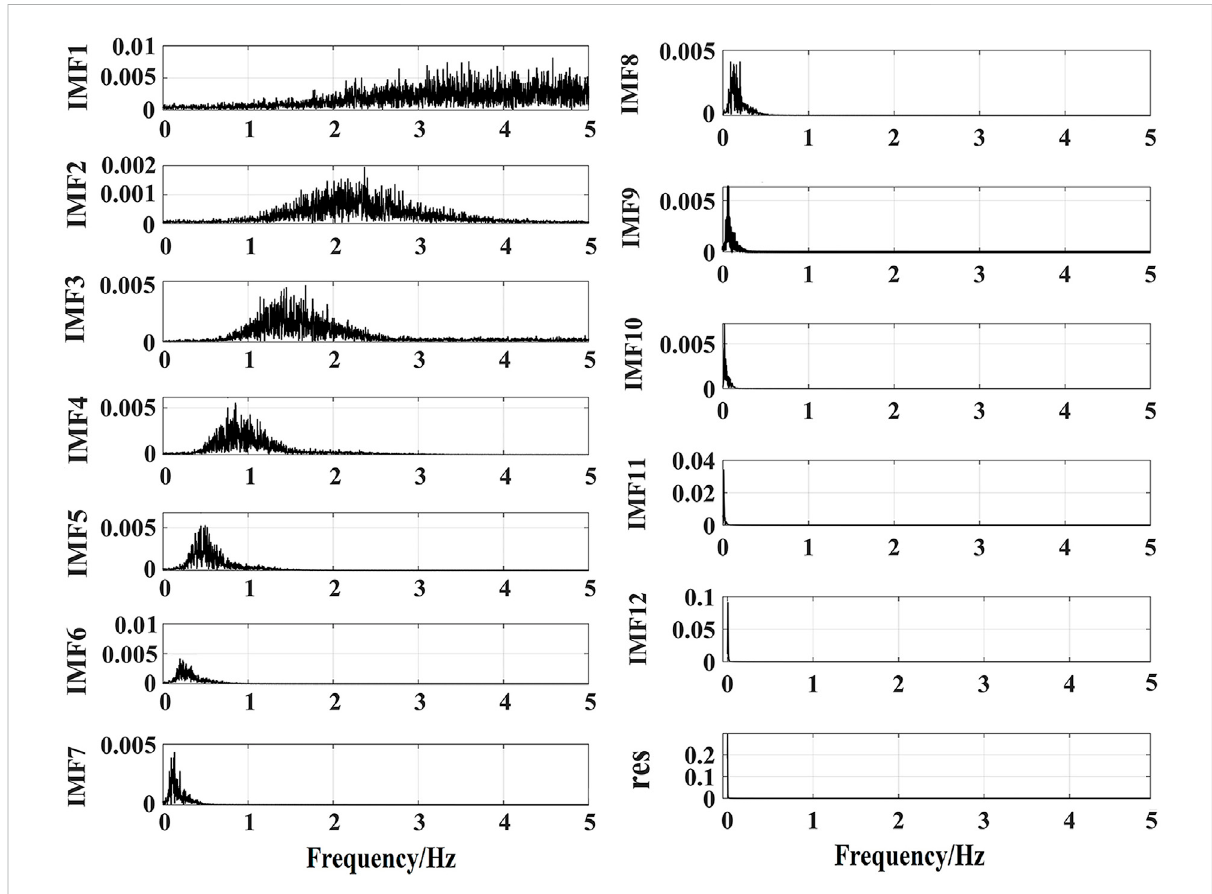
FIGURE 5 Frequency spectrum of IMF1-IMF12.